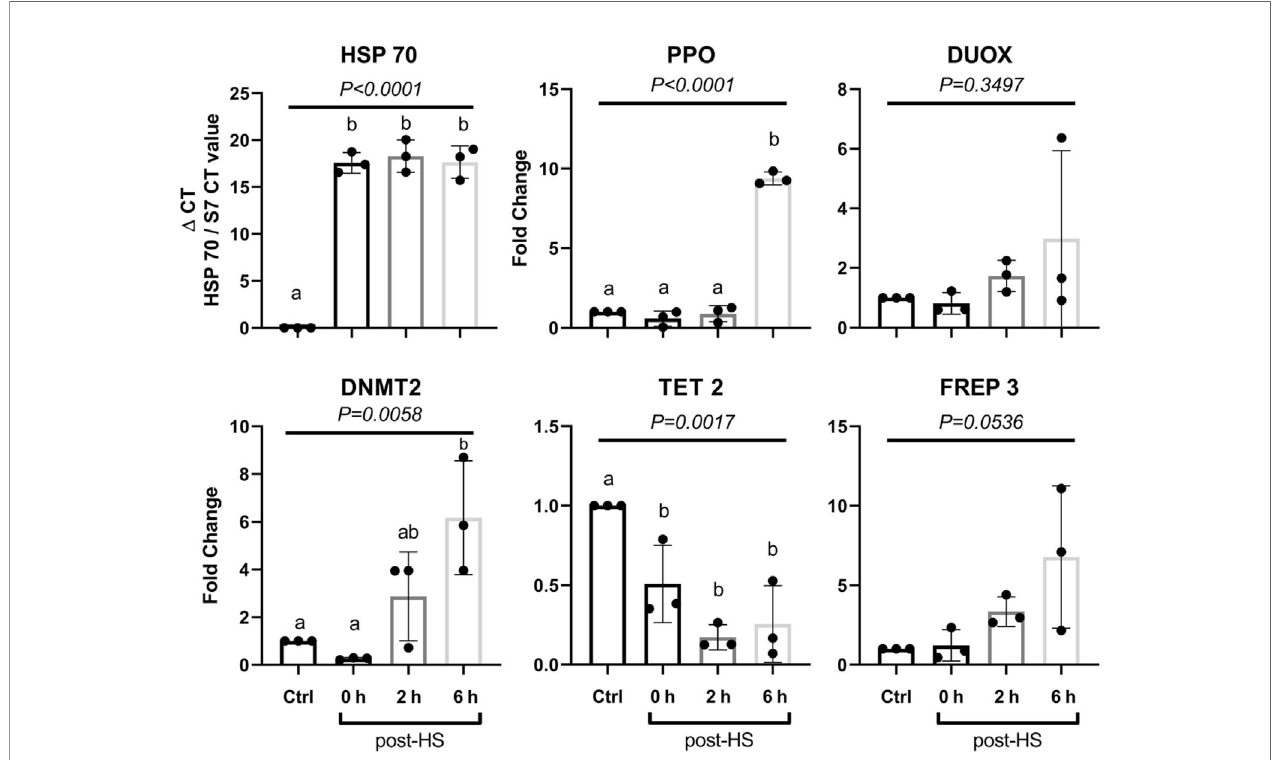
FIGURE 4 | Gene expression at different times post-heat shock in whole body. Gene expression was evaluated immediately (0 h), at 2, and 6 h after 30 min of exposure at 37°C (heat shock) in whole mosquitoes body. Data are indicated as mean ± SD. Data of three independent experiments were analyzed using ANOVA- one way followed by Tukey ’ s test. Different letters indicate statistical signi fi cance.